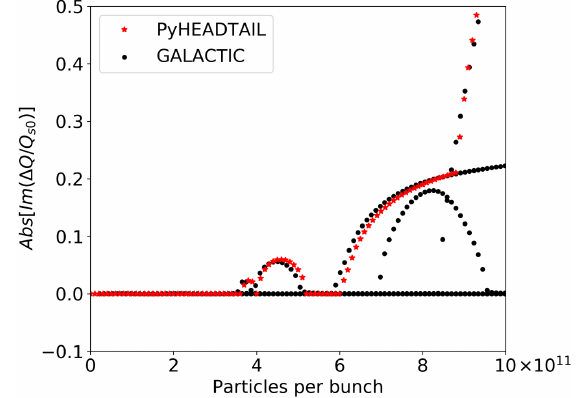
FIG. 16. Growth rates of the transverse mode coupling insta- bility as a function of the bunch intensity given by P y HEADTAIL and GALACTIC (black dots). Observe that GALACTIC gives the growth rates of several unstable